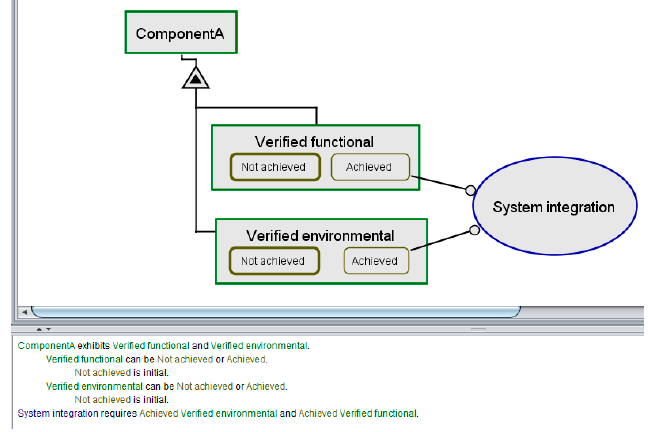
Figure 10. PROVE composite-state construct represented using OPM.